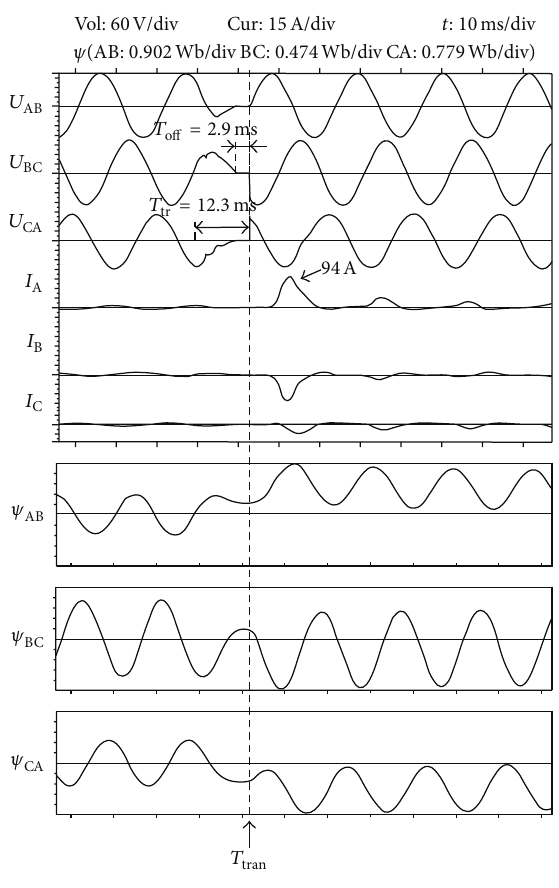
Figure 15: Waves of the transfer strategy without flux linkage DC component elimination (three-phase voltage sag). From the top to bottom, they are AB, BC, and CA phase transformer voltage, A, B, and C phase load current, and AB, BC, and CA phase transformer flux